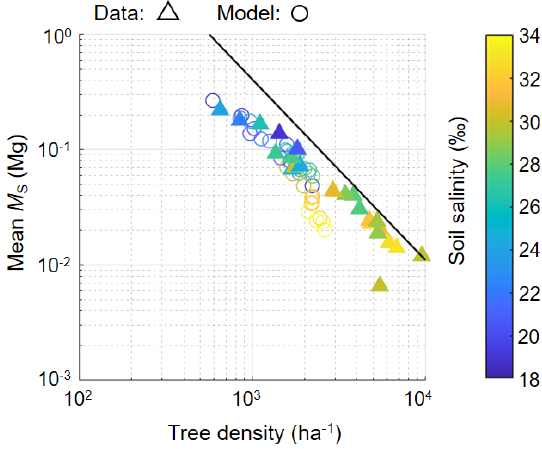
Figure 9. The relationship of tree density and mean individual stem biomass ( M S ). Triangles show field data while circles show mod- eled values from one of the ensemble simulations with different soil salinity settings (from 18‰ to 34‰ with 2‰ increments) plotted from 300–450 years (with interval of 50 years), which are in steady states in terms of forest structural variables (see Fig. 7). Note that trees with DBH < 0.05m were not counted in calculating tree den- sity and mean M S . The line represents the full density curve pro- posed by Tabuchi et al. (2013): y = 20389 x − 1 . 567